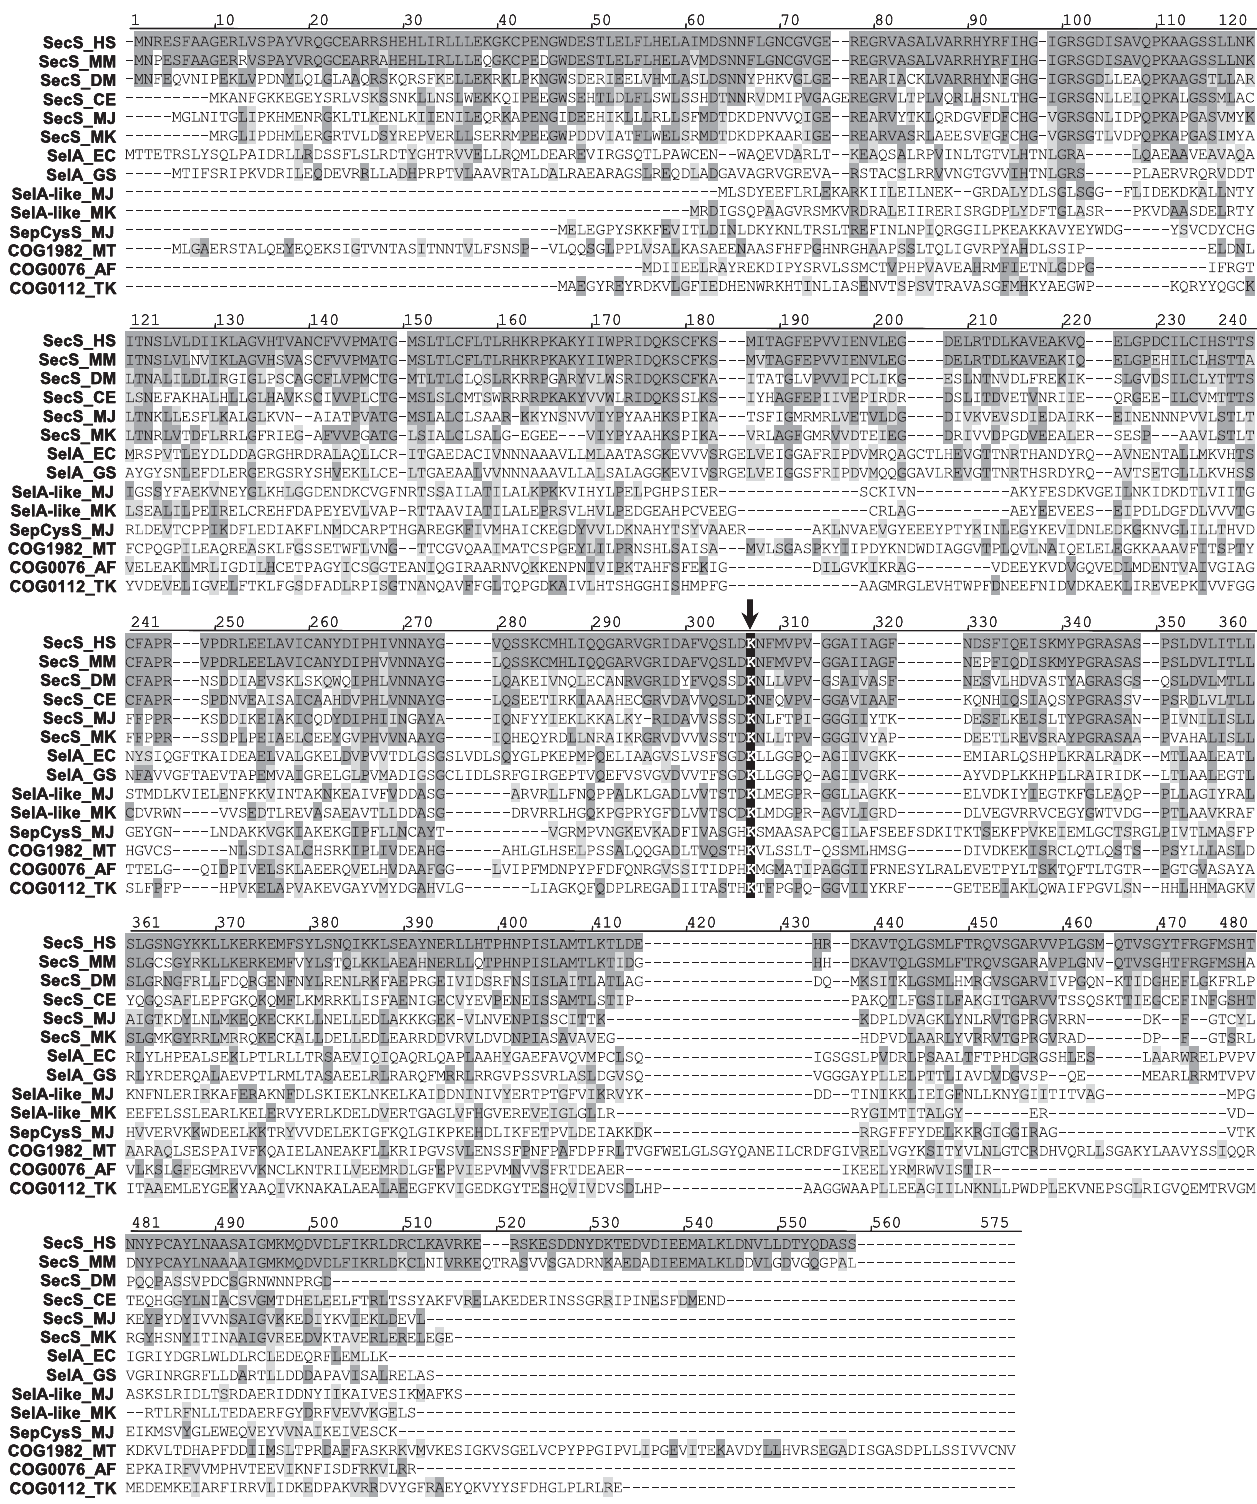
Figure 2. Multiple Alignment of SecS, SelA, SelA-Like, and Other PLP-Dependent Protein Sequences GenBank accession numbers for the sequences are given in the Accession Numbers summary. The active site lysine (K), which is PLP-binding residue, is indicated with an arrow.